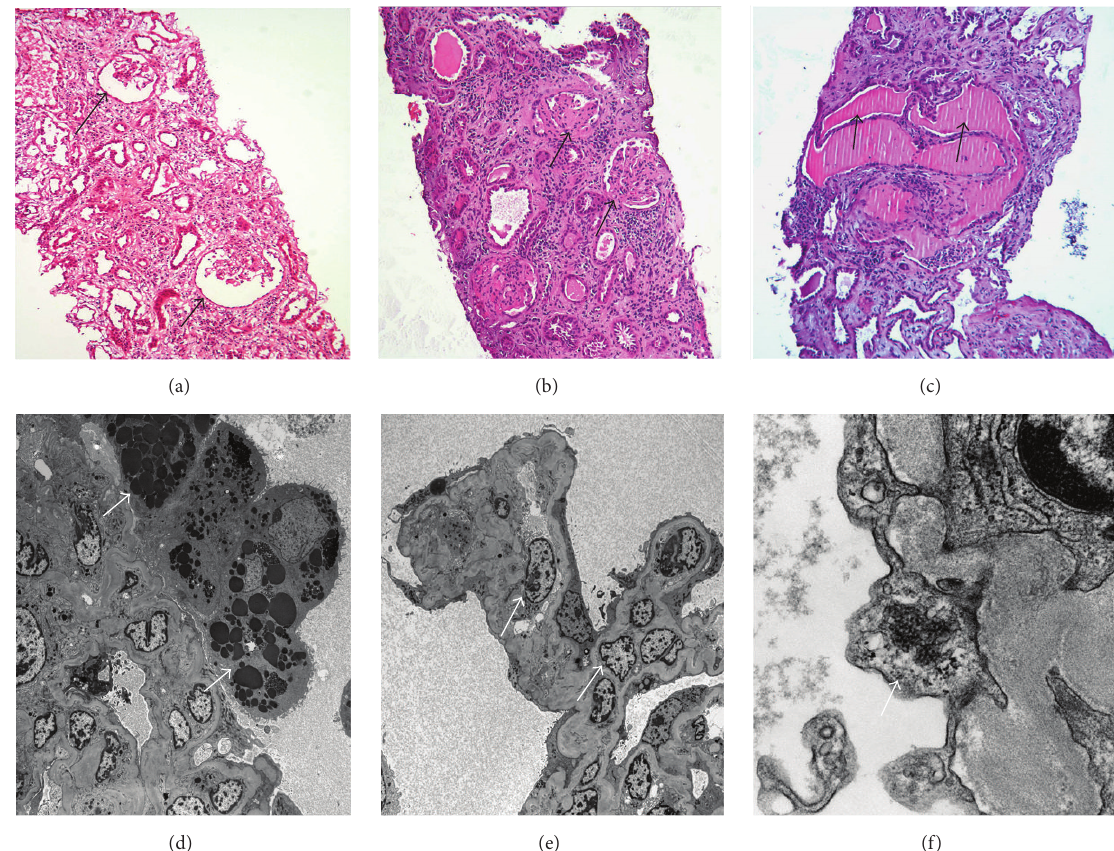
Figure 2: Light microscopy. (a) Shrunken glomerular tuft with dilated urinary space (arrows), (b) glomerular segmental sclerosis (arrows) with interstitial fibrosis, tubular degenerative/regenerative changes, and (c) tubular cystic dilatation (arrows) (H&E stain: (a) × 10, (b) × 10, and (c) × 20). Electron microscopy. (d) Several protein droplets in visceral Bowman’s epithelium (arrows), (e) mesangial sclerosis with increased mesangial cellularity (arrows), and (f) dilated urinary space and tubuloreticular inclusions in tuft endothelium (arrow). No disruption or electron dense deposits in GBM (EM: (d) × 1900, (e) × 1900, and (f) × 30000).